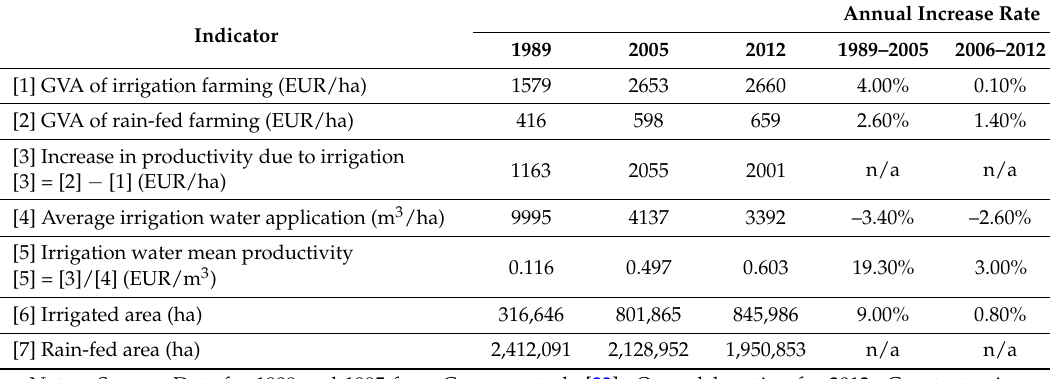
Table 4. Irrigation water mean productivity in the Guadalquivir RB. GVA: gross value added.